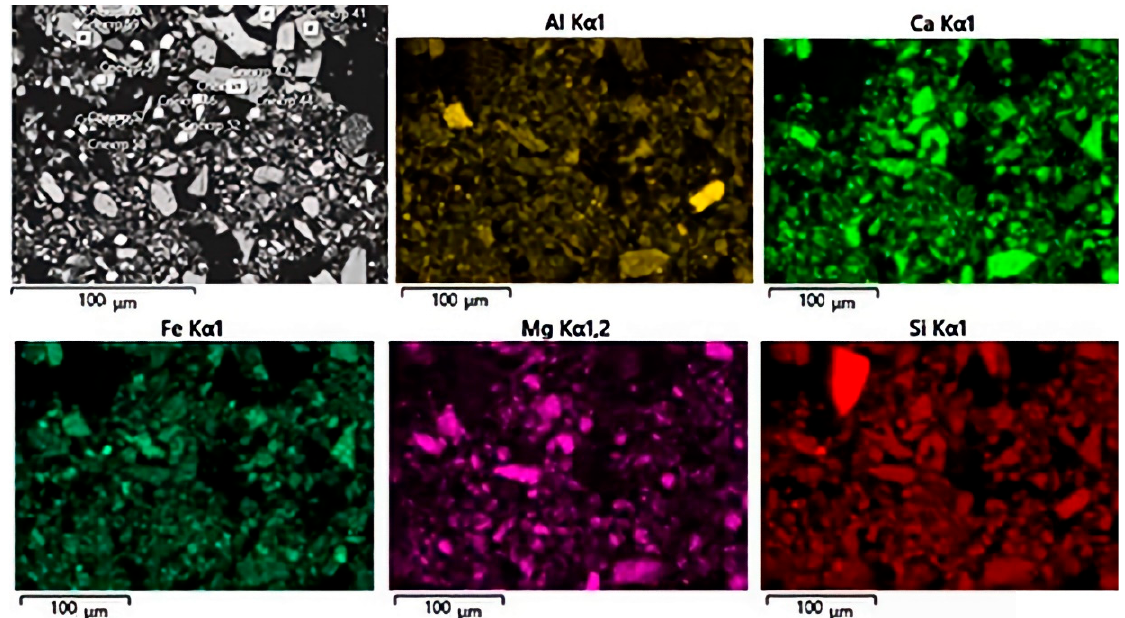
the sample sufficiently uniformly.